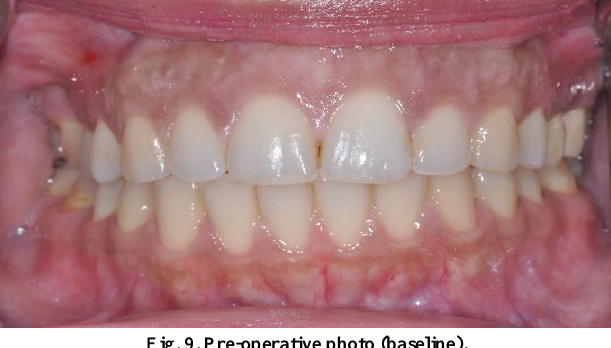
Fig. 9. Pre-operative photo (baseline).